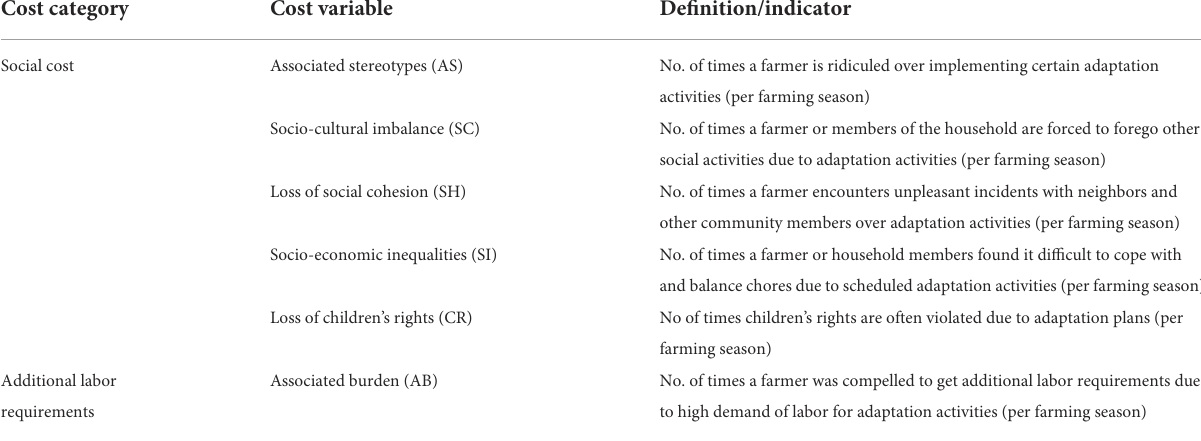
TABLE 4 Post-adaptation cost categories, variable and